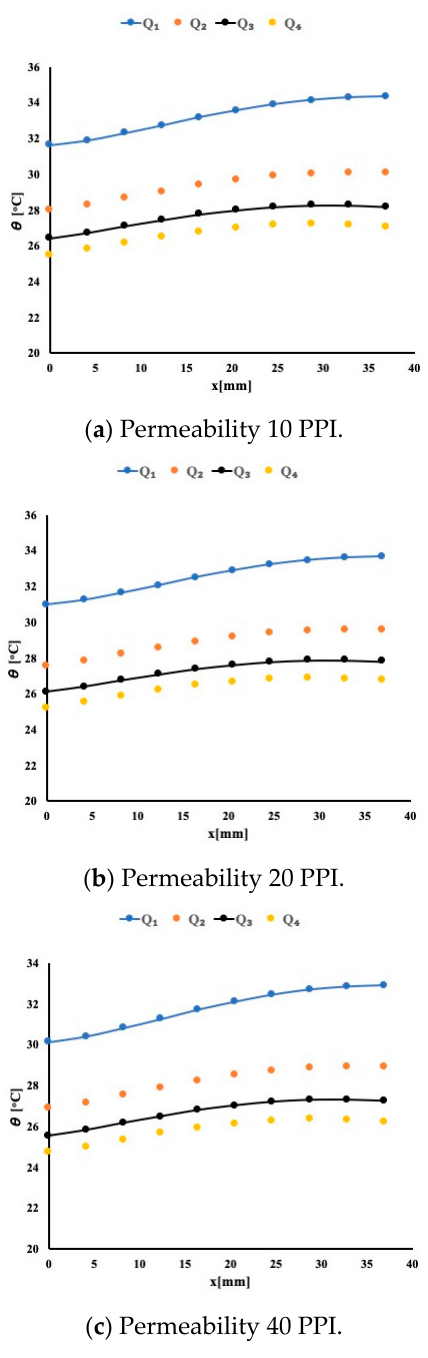
Figure 3. Temperature distribution with water as working fluid.